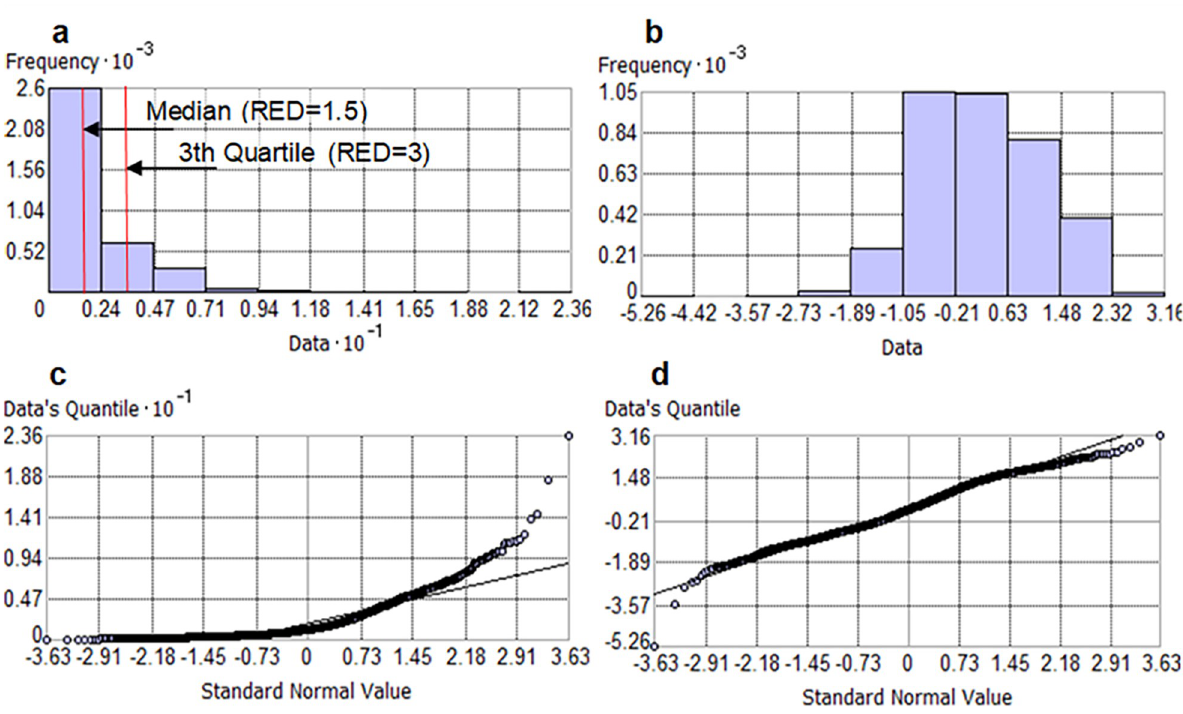
Fig 4. Exploratory data analysis and verification of normality of rainfall erosivity density (RED) data. a) Distributional frequency on the original RED data and b) after log-normal transformation; c) QQ-Plot of the theoretical and estimated distribution of the original RED data and d) after log- normal transformation. Warning and alert thresholds (MJ hm -2 h -1 ) are shown in a).